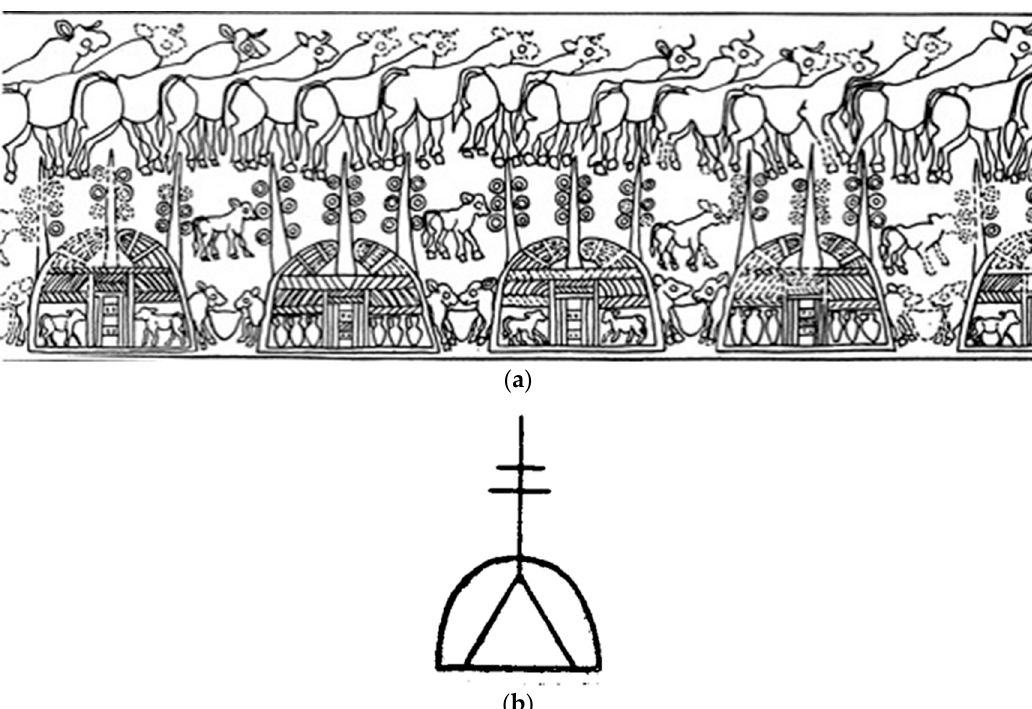
Figure 15. ( a ) Cylinder seal depicting cows emerging from the cow pen (Delougaz 1968: Figure 11). ( b ) Archaic sign TÙR, cow